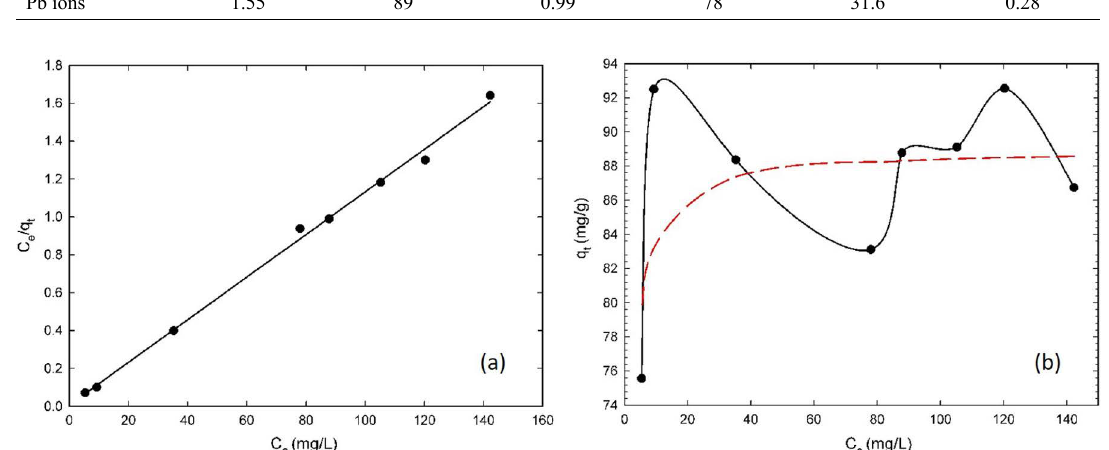
Figure 7. Isotherms plot for sorption of Pb by natural HA (a) Langmuir (b) Freundlich